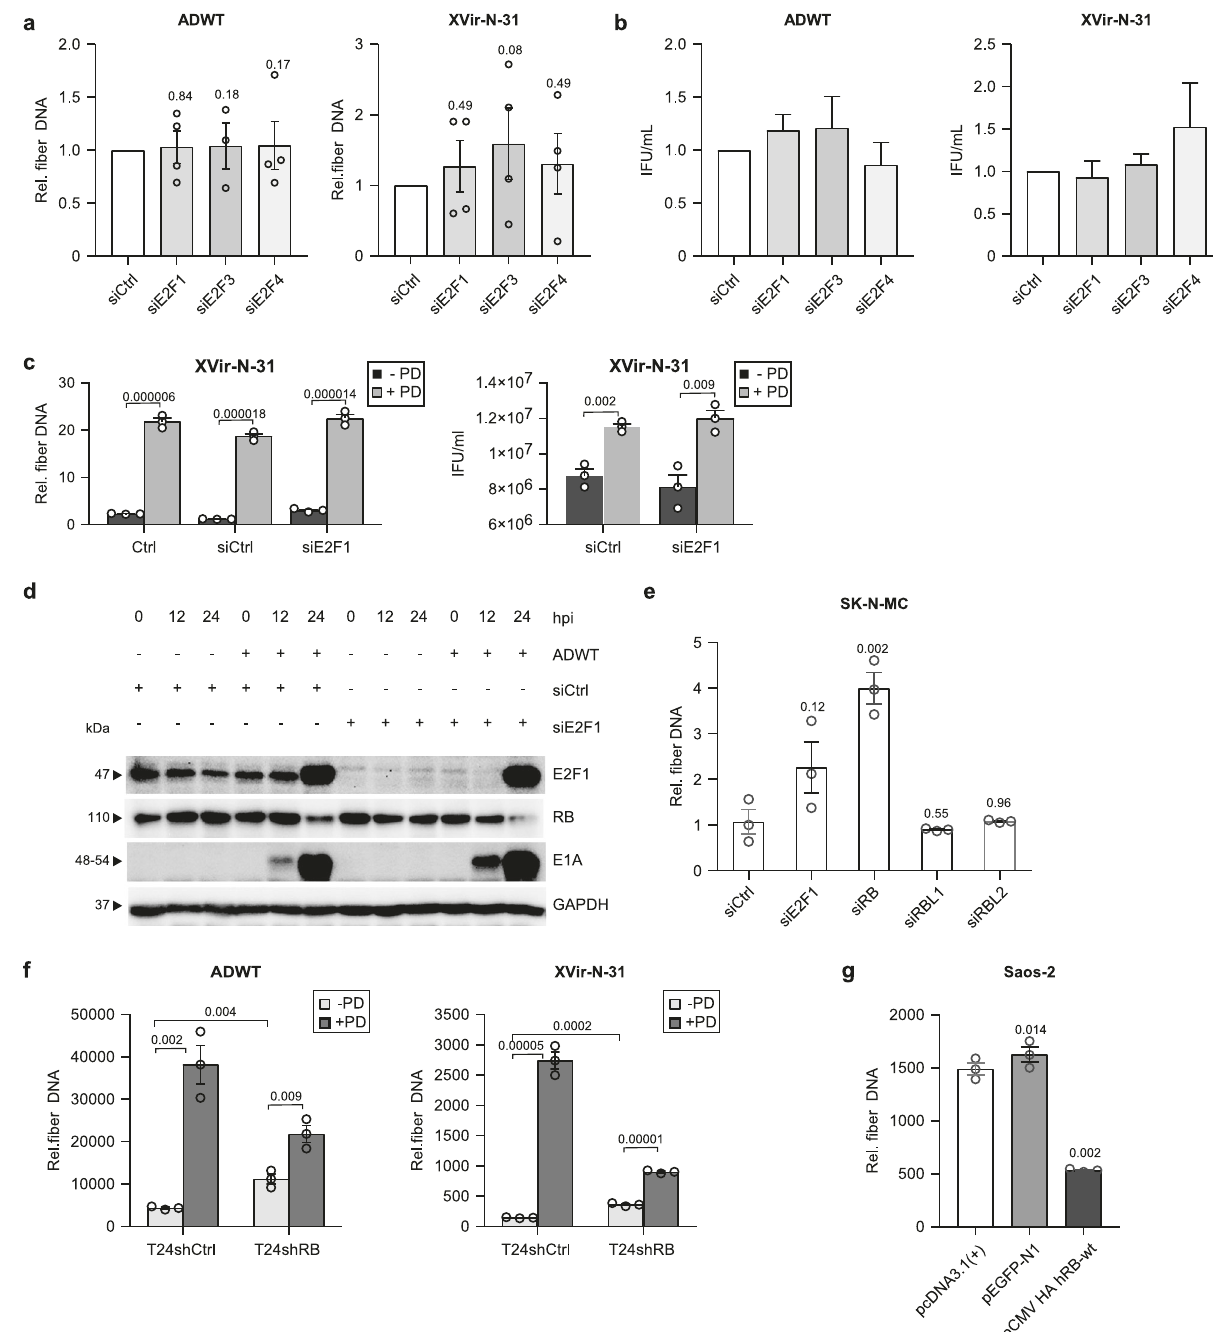
Fig. 5 | RB but not E2F1 expression level is the decisive factor for viral genome replication.a , b siRNA-mediatedknockdownofoneofE2F1,3and4wasperformed with siPOOL technology in T24 cells infected with ADWT or XVir-N-31 (MOI 50). a Viral genome replication was analyzed at 24hpi. n =4. b Quanti fi cation of viral particleswas performedby a hexon titer test and presented as infectiousunits per milliliter (IFU/ml). n =2, mean±SE. c Viral replication was analyzed in T24 cells transfected with siE2F1 pool and treated with 500nM Palbociclib for 24h, and infected with XVir-N-31 (MOI 50). d siRNA-mediated knockdown of E2F1 was per- formed with siPOOL technology in T24 cells and infected with ADWT or XVir-N-31 (MOI50).Proteinlevelsweredetectedbyimmunoblottingatindicatedtimepoints for E2F1, RB, and E1A proteins. GAPDH was used as a reference protein. e SK-N-MC cellsweretransfectedwithsiRNAsagainstE2F1orRBorRBL1(p107)orRBL2(p130)